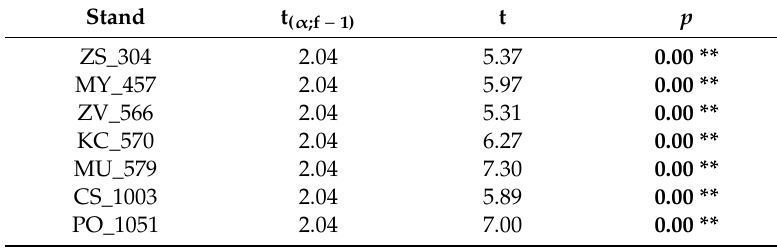
Table 7. Di ff erences of the average summer temperature (T VII–IX ) from the temperature normal of bold, t ( α ;f − 1) is the critical value, and t is the test